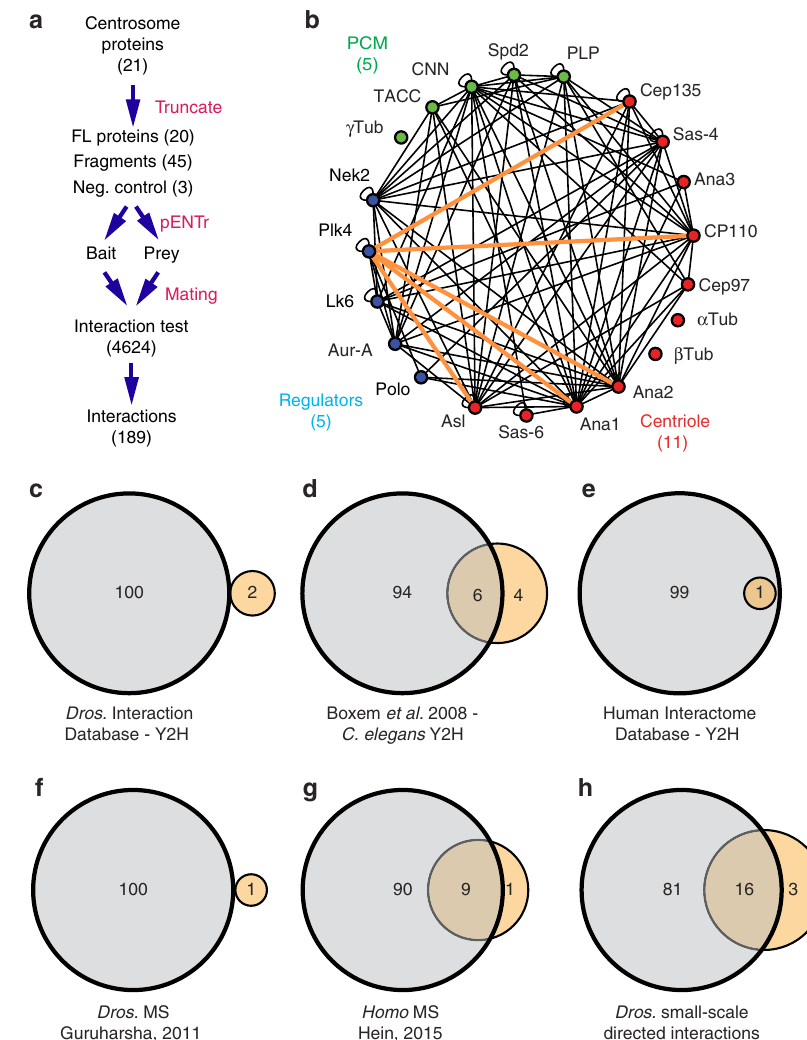
Figure 1 | Y2H screen to determine the centrosome interactome. ( a ) Workflow of the centrosome array-based Y2H screen. ( b ) Summary of all interactions among the 21 centrosome proteins. Interaction details are summarized in Supplementary Material. Orange lines highlight the interactions made by Plk4 with proteins of the centriole. ( c – h ) Venn diagrams showing the overlap of the PPIs identified in this study (beige) and other studies (grey; Supplementary Table 3). ( c ) Overlap with Y2H data in the Drosophila Interaction Database 24 . ( d ) Overlap with C. elegans Y2H data from Boxem et al. 10 . ( e ) Overlap with Y2H data in the Human Interactome Database 25,26 . ( f ) Overlap with a high-throughput pull-down/mass spectrometry study in Drosophila 27 . ( g ) Overlap with high-throughput pull-down/mass spectrometry study in HeLa cells 28 . ( h ) Overlap with direct PPIs identified in small-scale studies in Drosophila